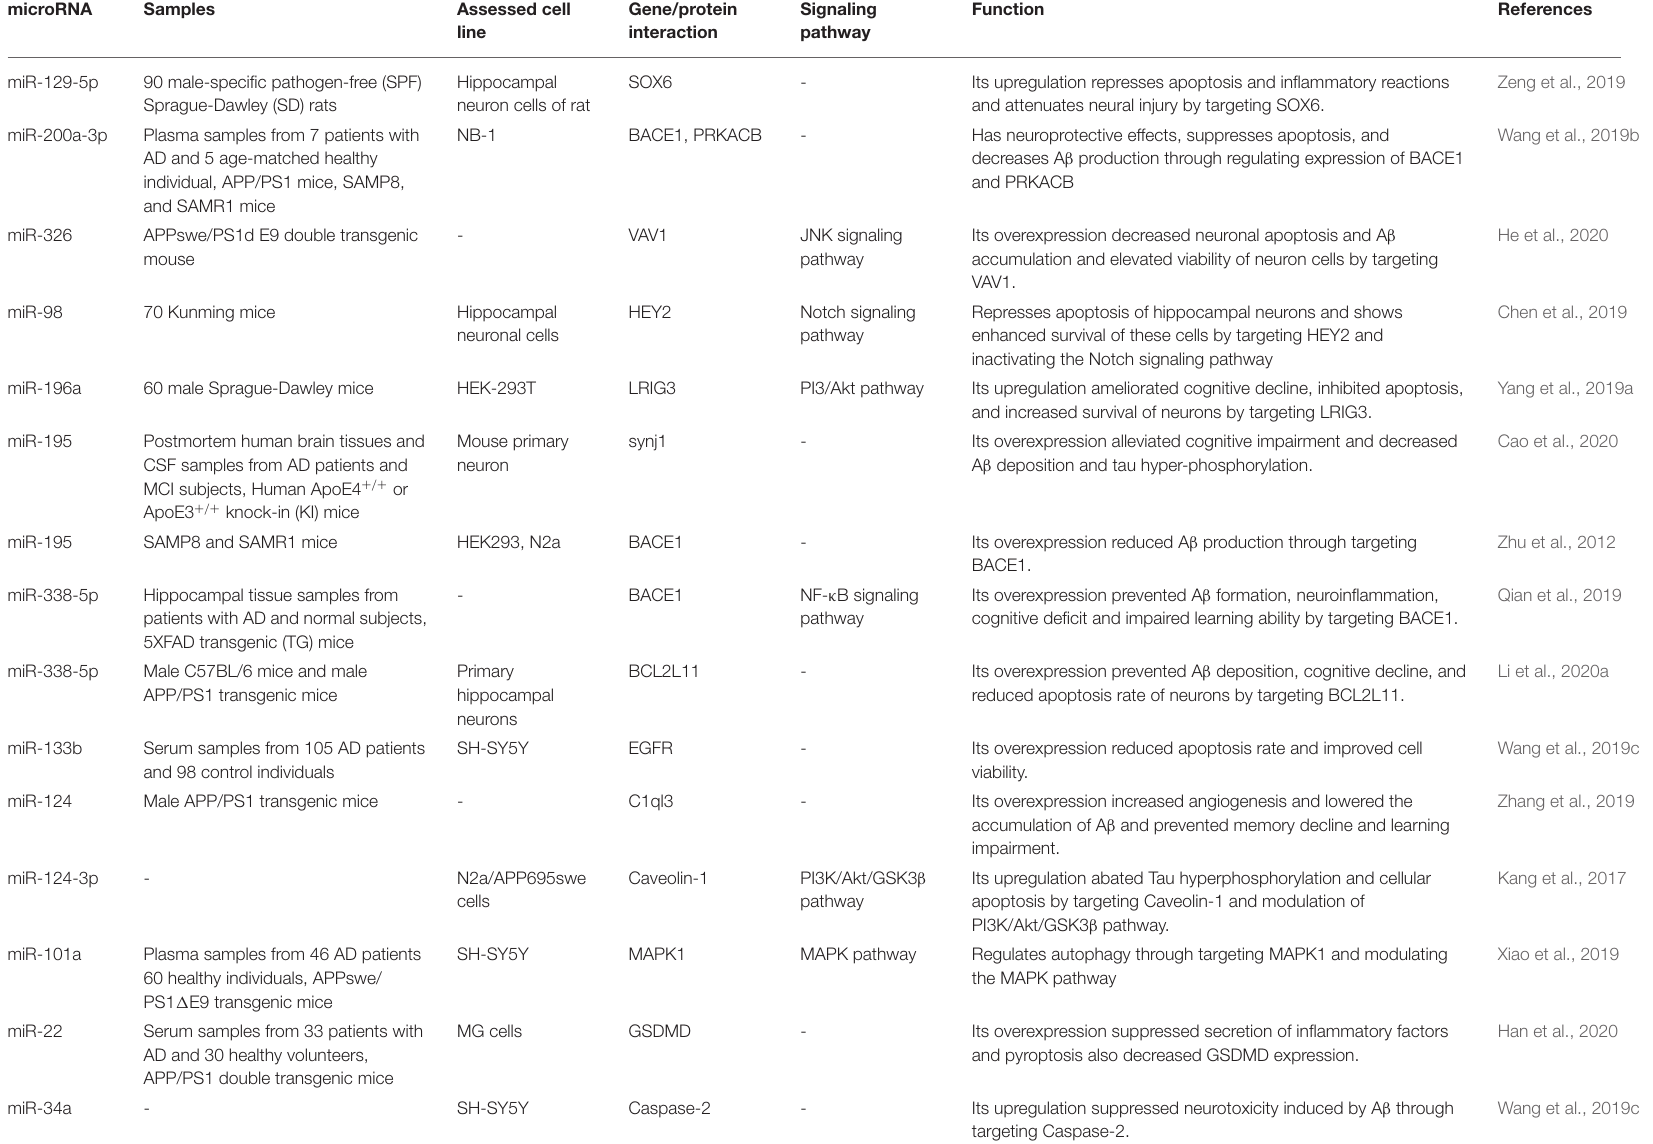
TABLE 1 | Downregulated miRNAs in AD subject, animal models of AD, and related cell lines and their functions in progression of AD. microRNA